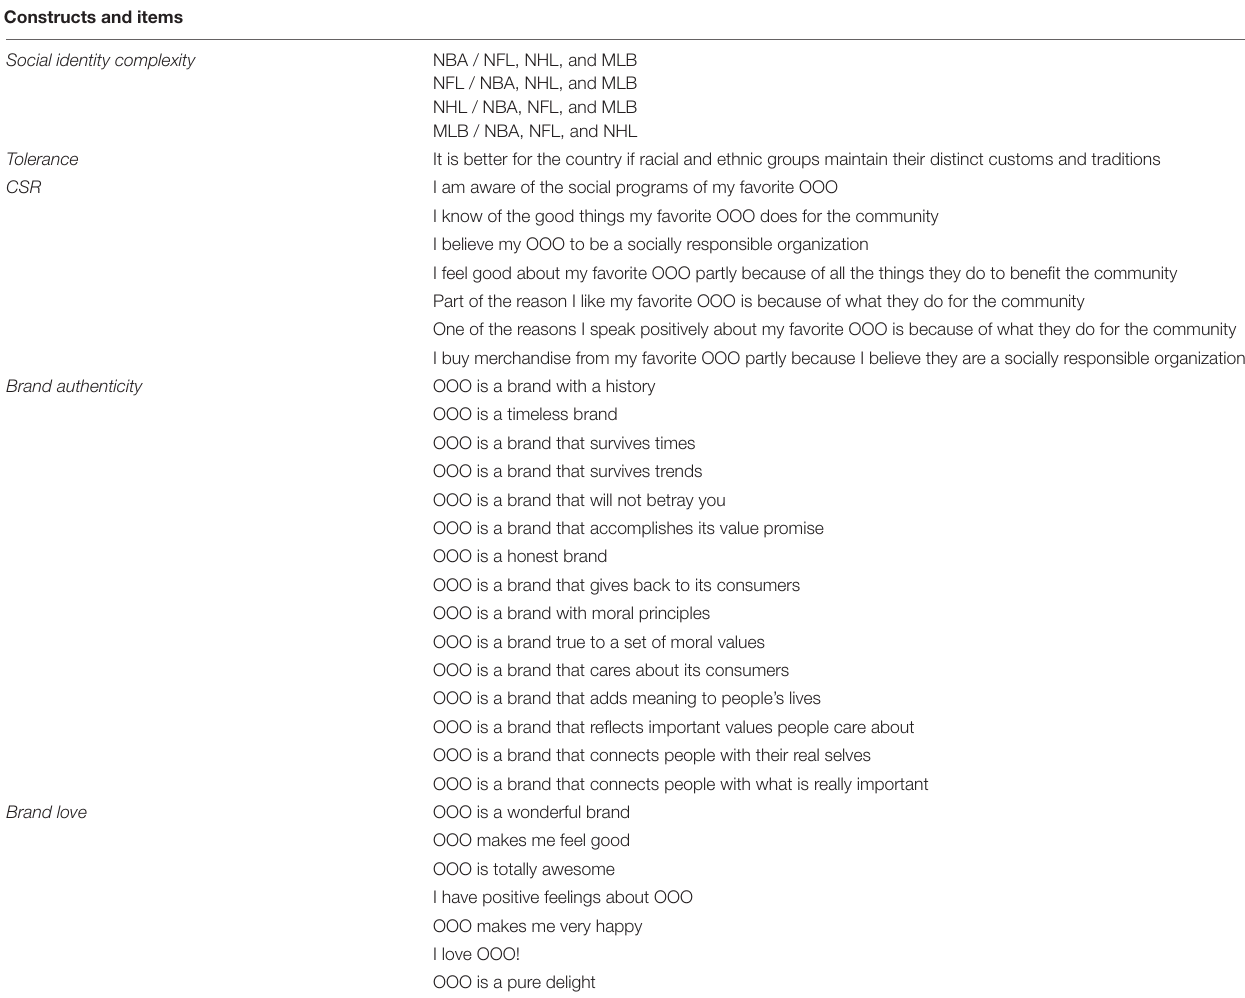
TABLE A1 | Measurement